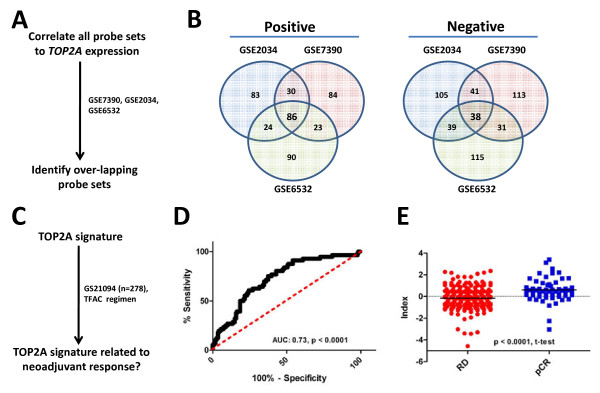
TOP2A index predicts response to anthracycline containing chemotherapy. A) Experimental strategy to identify the TOP2A index. B) TOP2A co-expressed probesets within the three discovery cohorts. C) Experimental strategy to validate the TOP2A index. D) ROC Analysis of TOP2A index scores and response to T/FAC neoadjuvant chemotherapy (AUC: 0.73, p < 0.0001). E) TOP2A index scores of patients who experienced pCR or had RD after neoadjuvant chemotherapy ( p < 0.0001, t-test).